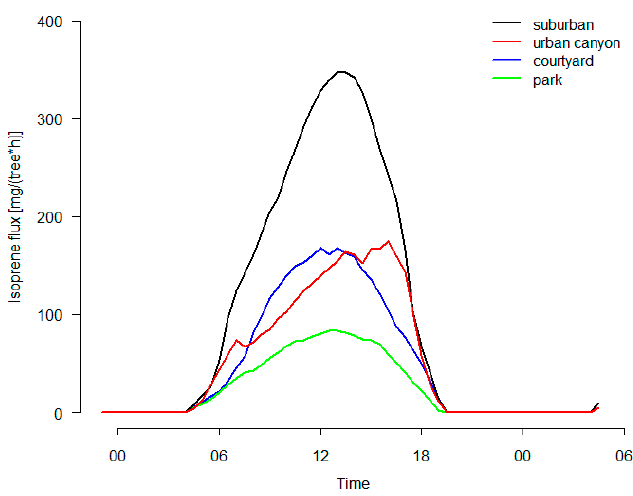
Figure 10. Diurnal simulated profile of isoprene emission capacity for 4 scenarios.